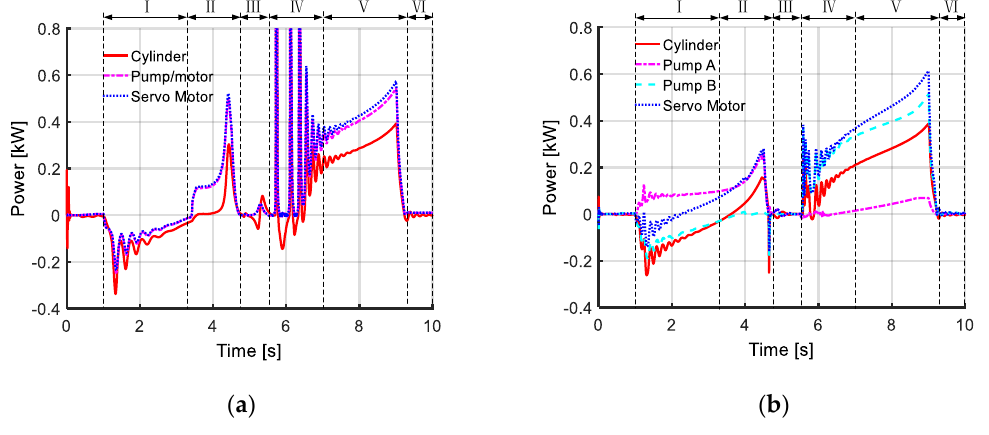
Figure 12. Power consumption and regeneration: ( a ) SPC, ( b ) DPC.